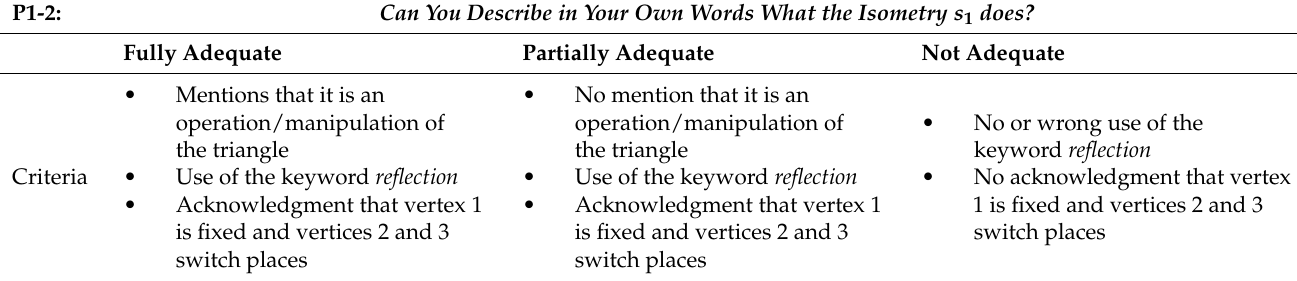
Table A9. Coding manual for the paraphrasing of key idea 1.